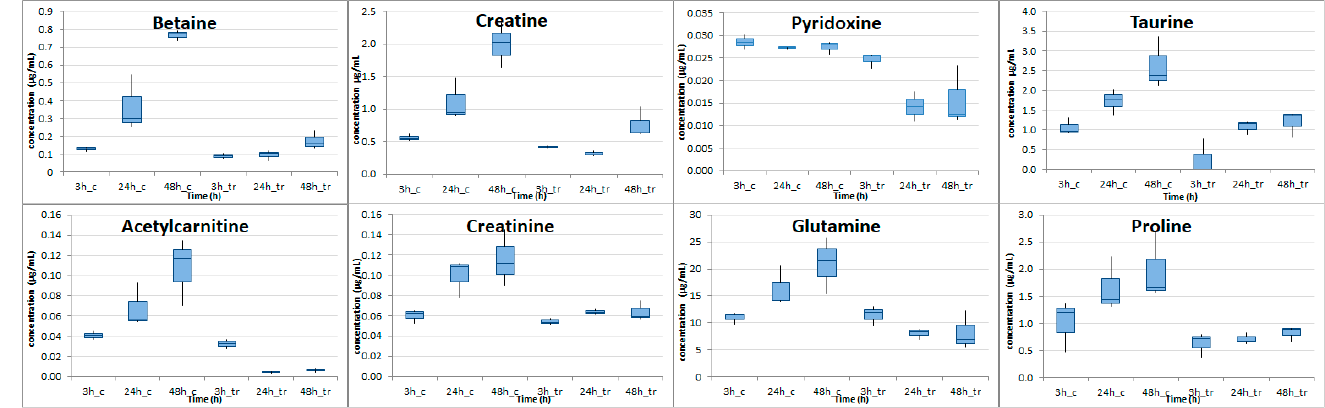
Figure 4. Boxplots illustrating the concentrations of metabolites with p < 0.05 at 24 h and 48 h in the intracellular material of cocaine-treated HepG2 cells compared to the control HepG2 cells (c stands for control, tr for cocaine-treated cells). Table 2. Metabolites that were detected in cell medium and their p -value and fold change value at each time point; the compounds are listed based on their p -values at 48 h (cocaine vs. control), increasing from top to bottom. Control ( µ